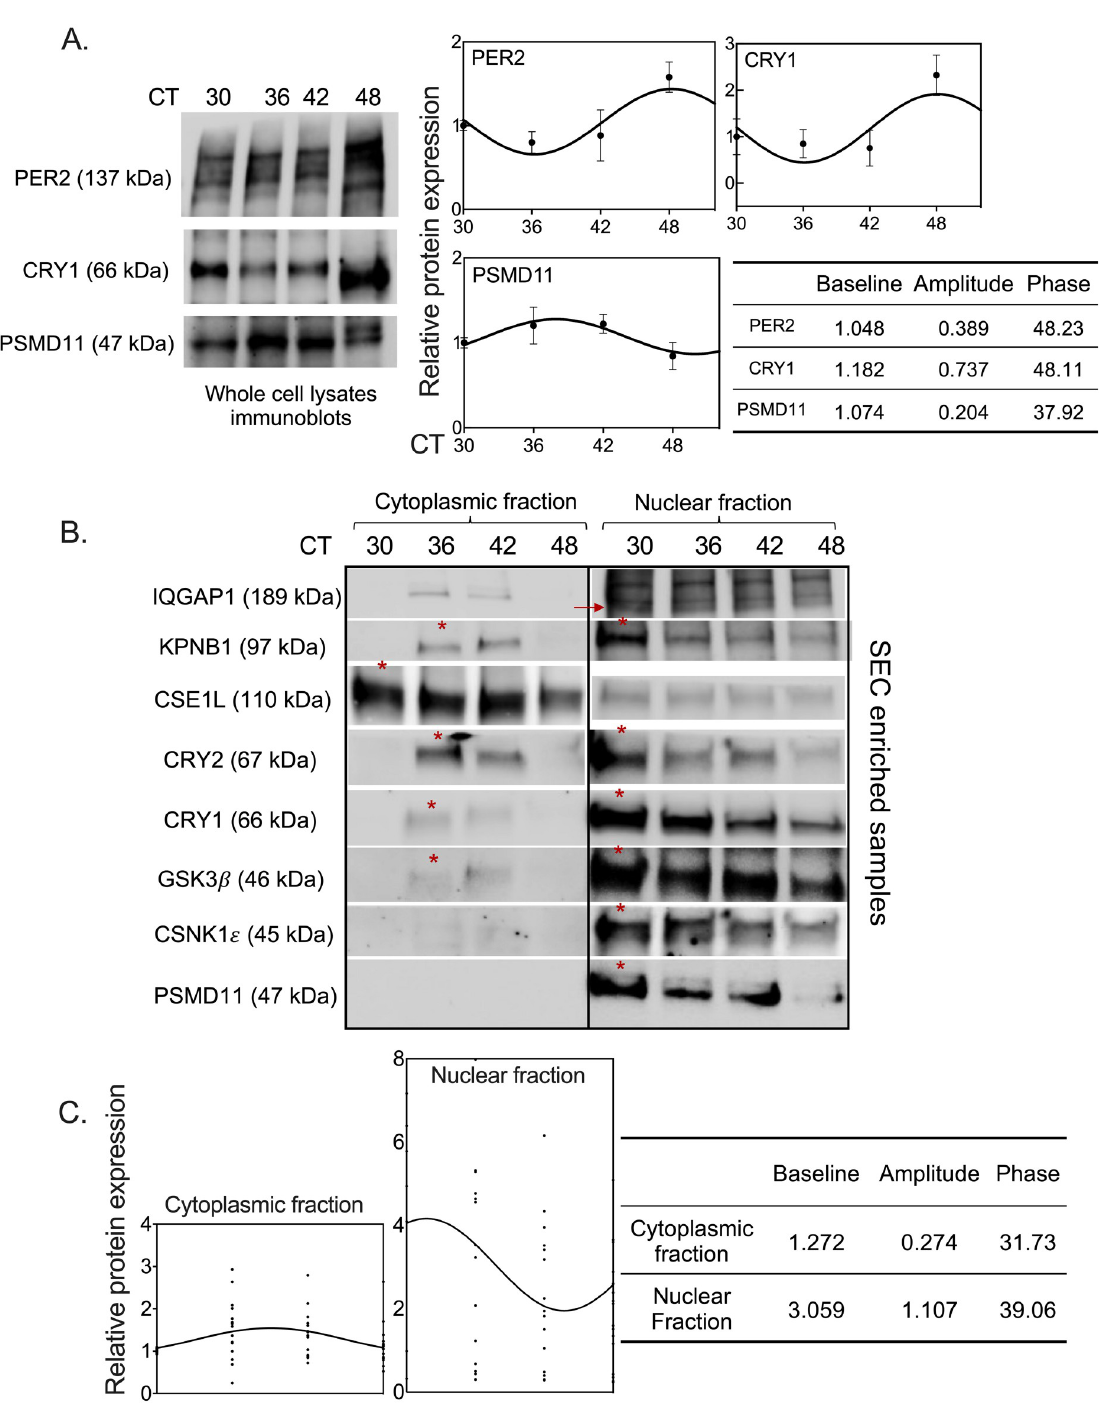
PLOS ONE | https://doi.org/10.1371/journal.pone.0283463 March 24,